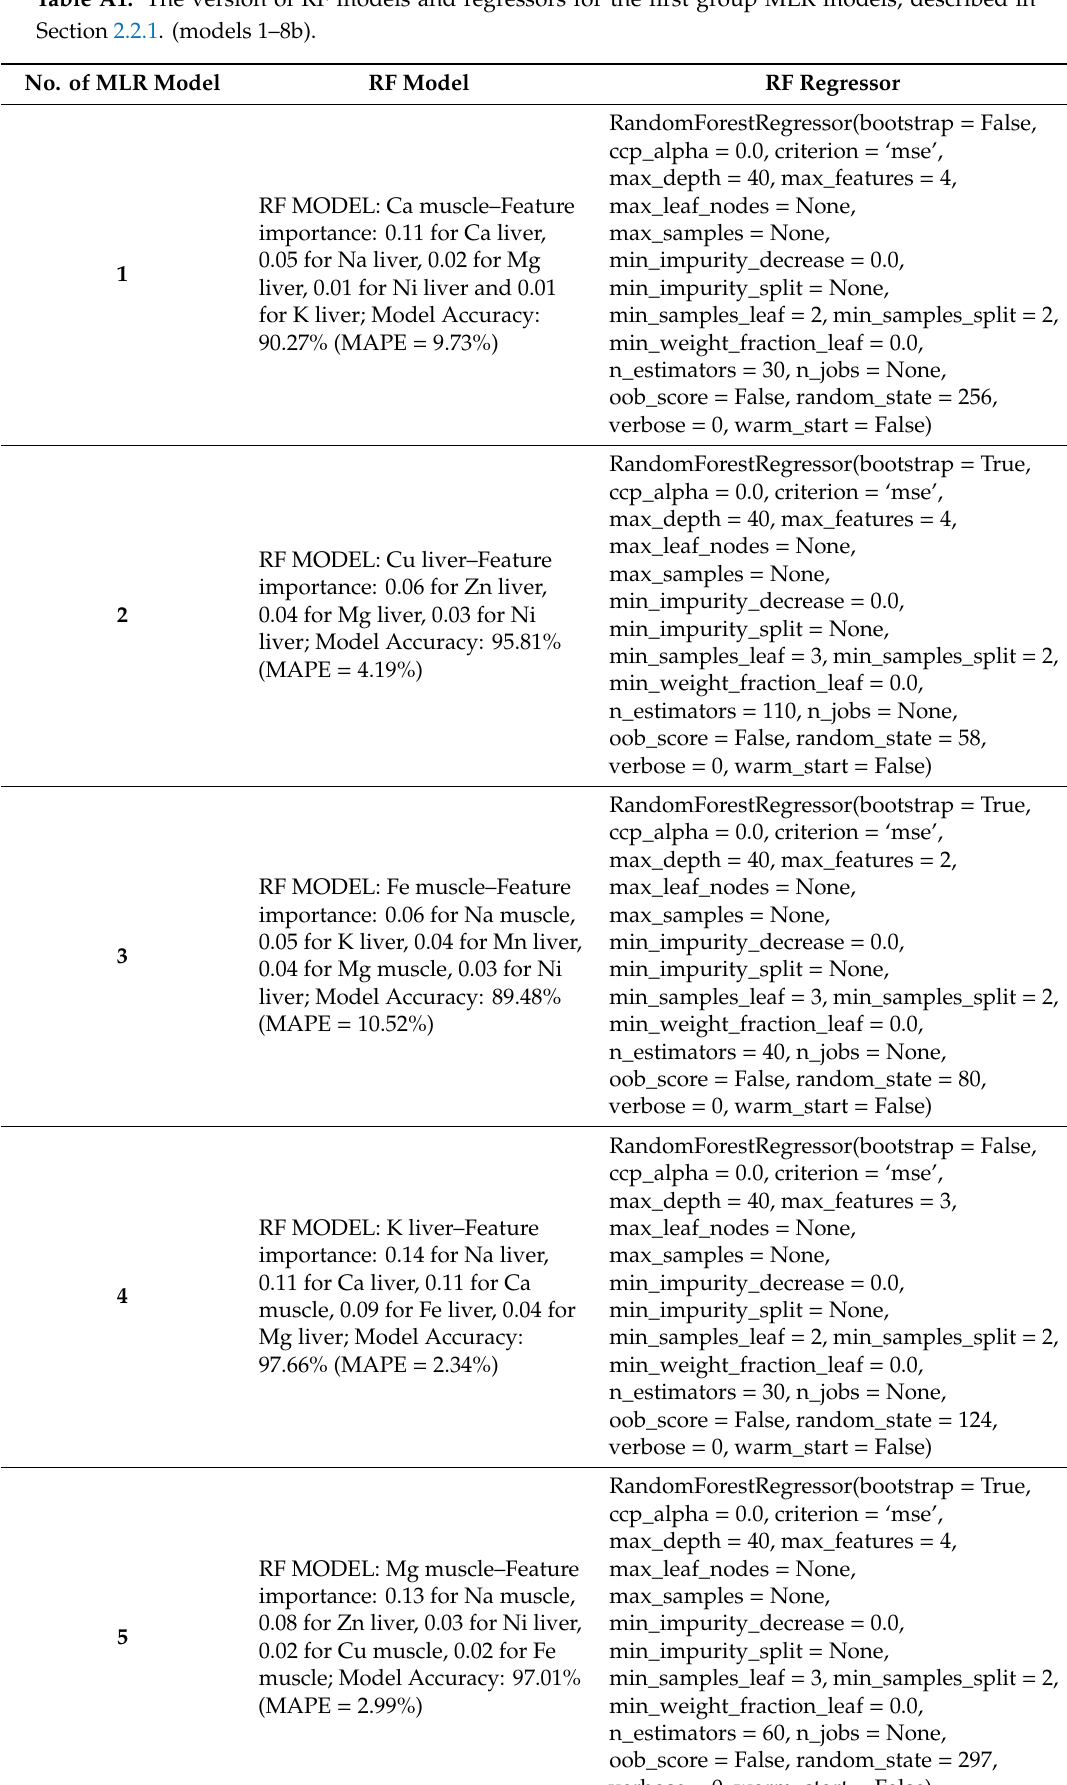
Table A1. The version of RF models and regressors for the first group MLR models, described in Section 2.2.1. (models